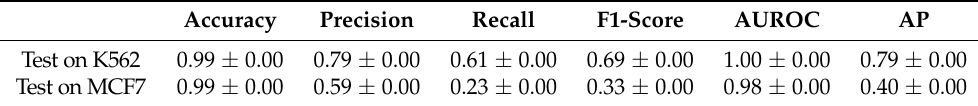
Table 6. Cross-cell-line prediction results (HepG2-trained